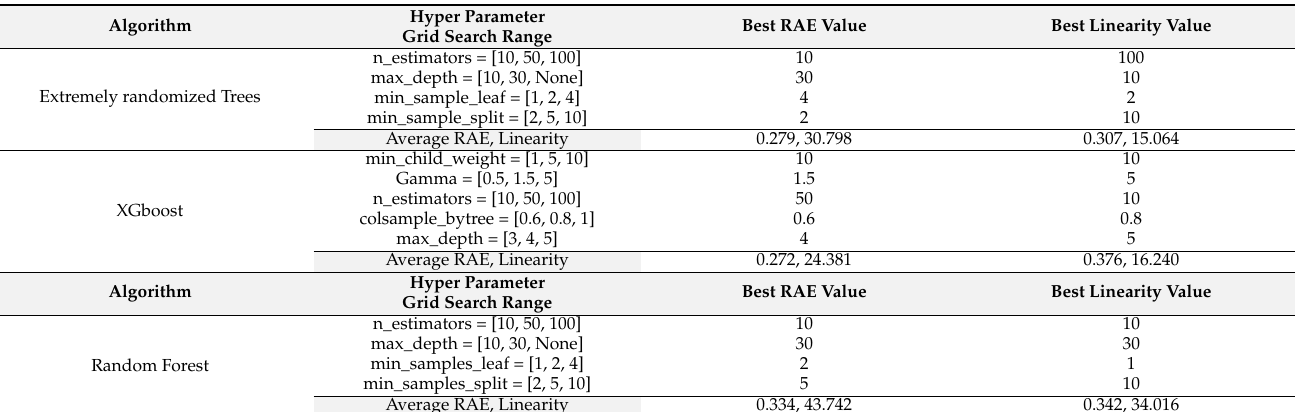
Table 2. Comparison of seven regression methods using cross-validation with T RUL = 70 days trained on A/C dataset. The best averaged RAE and Linearity results and the parameters are obtained through grid search for each algorithm, and the grid search range is also specified in the